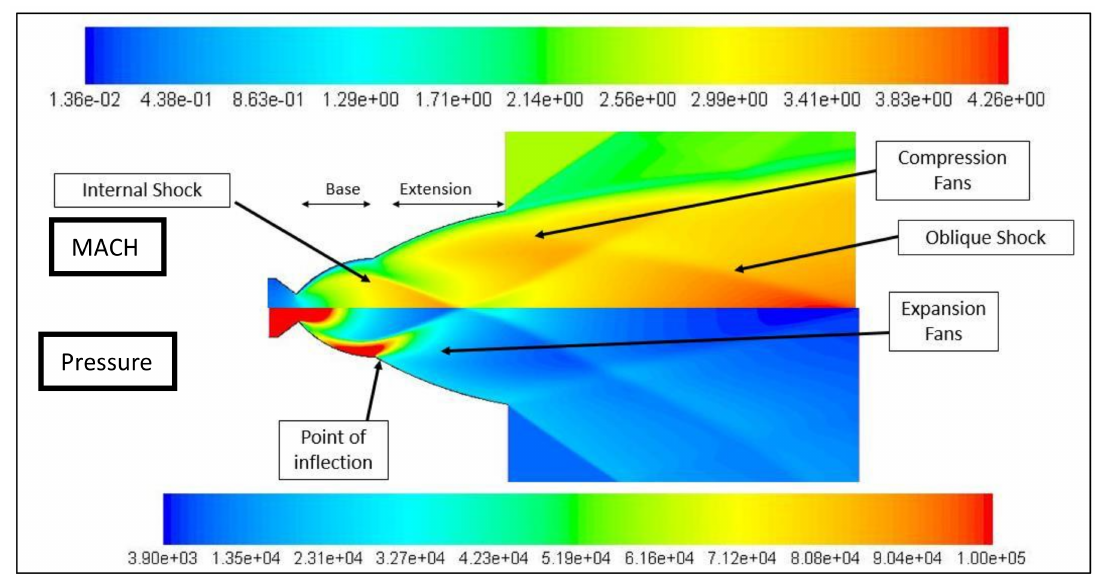
Figure 24. ( Top ) Pressure contour and ( Bottom ) Mach contour dual bell nozzle thrust = 1.89 × 10 6 N, NPR ≈ 76.5, H1 = 2.55, V1 = 1.65, V2 = 0.85, R1 = 7, R2 =